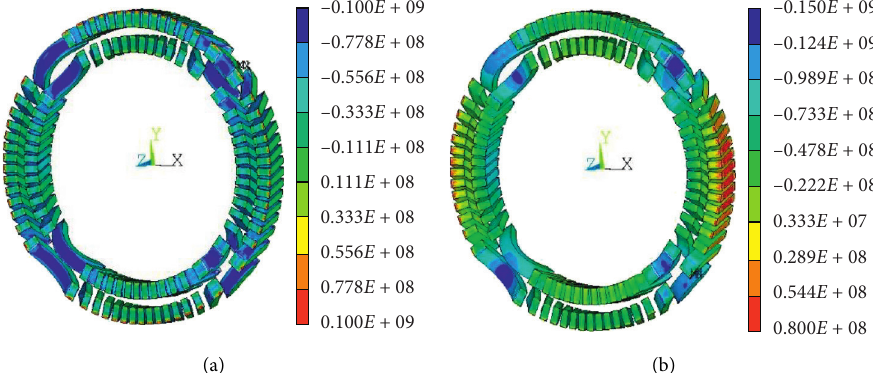
Figure 10: The radial (a) and azimuthal (b) stress distributions on the conductors when cooled down to 4.2 K.